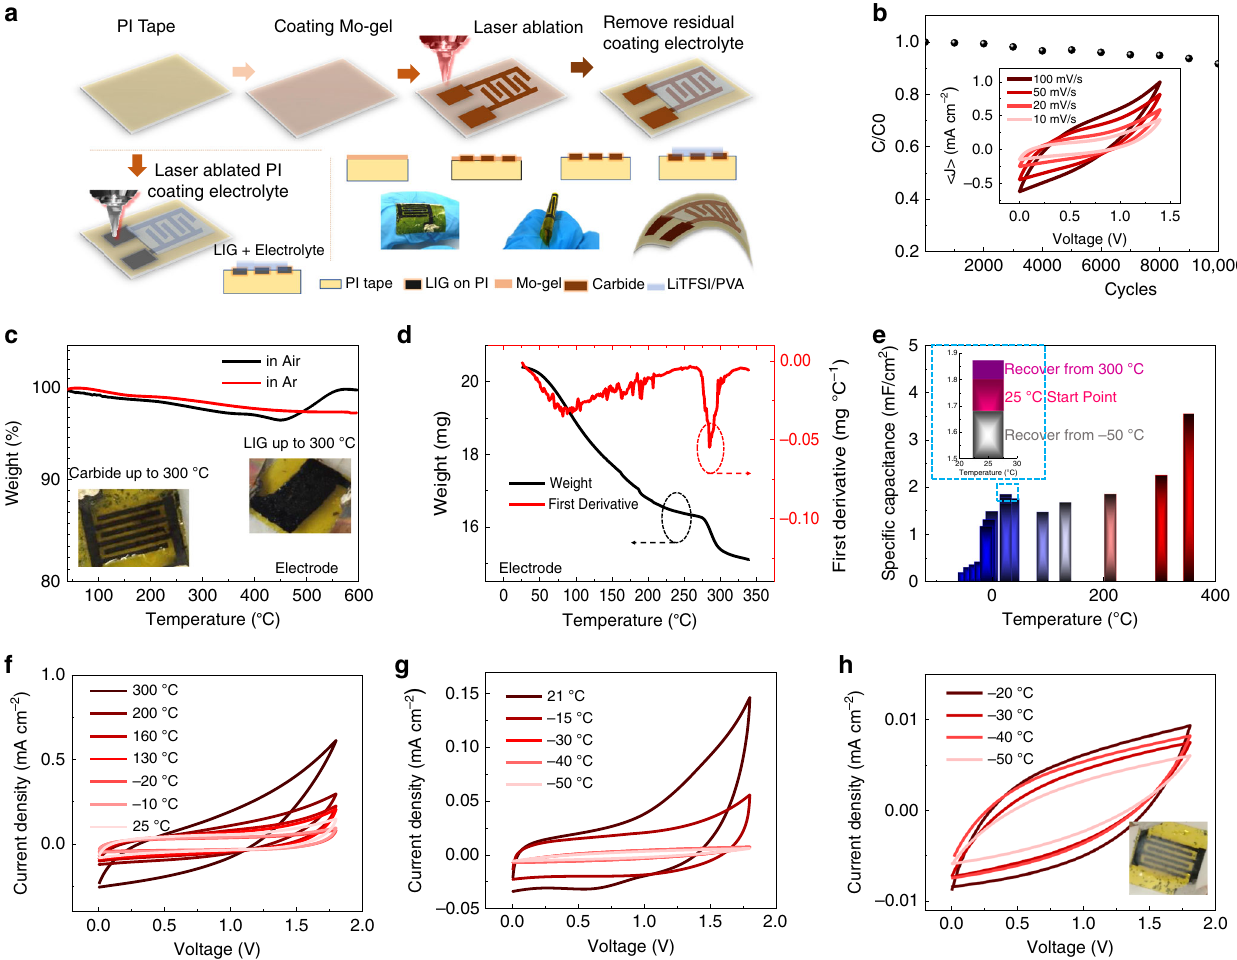
Fig. 2 Flexible supercapacitor made of MoC x with a wide operating temperature range. a Processing schematic of fabricating the fl exible MoC x supercapacitor. b Long-term retention of MoC x supercapacitor. Inset: cyclic voltammetry (CV) at different scanning rate. c Thermogravimetric Analysis (TGA) of MoC x . Inset, optical images of Carbide and LIG electrodes heated up to 300 °C. The molybdenum carbide electrodes could withstand temperatures reaching 300 °C while the laser-ablated graphene on PI in the below image decomposed to a black color. d TGA of Li-rich PVA electrolyte. e Speci fi c capacitance recovers during the temperature cycle, and high-temperature performance of the MoC x electrodes. Inset: speci fi c capacitance recovery in the temperature cycle. f CV results of carbide in LiTFSI/PVA/H 2 O electrolyte over the temperature cycle. g – h Low temperature performance of the MoC x